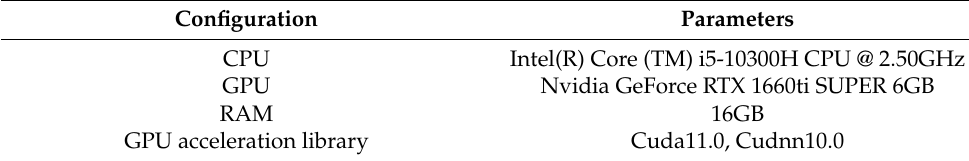
Table 1. Parameters of hardware and Software equipment.